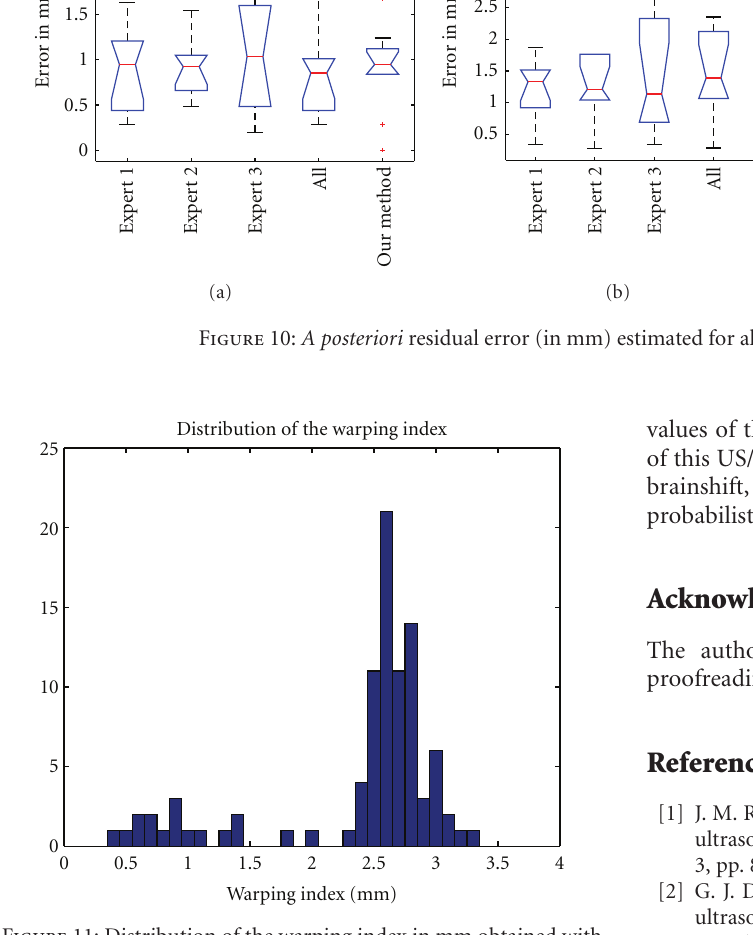
Figure 11: Distribution of the warping index in mm obtained with our